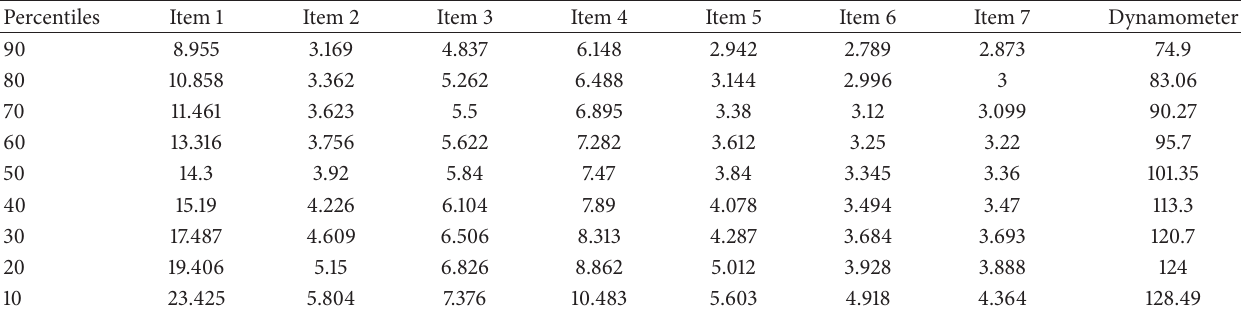
Table 21: 𝑛 = 82 , 20–94, dominant hand, educational instruction: secondary school.